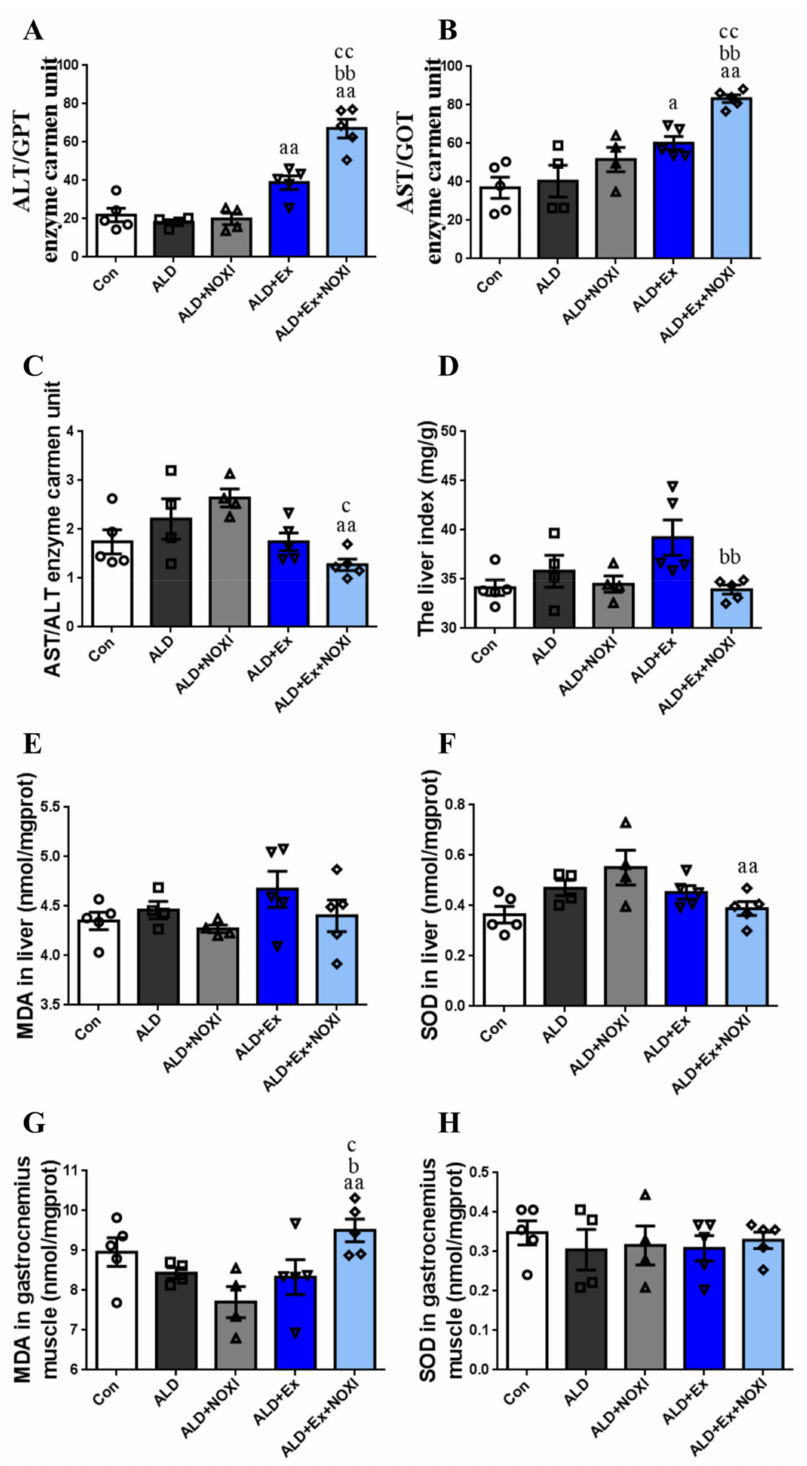
Figure 2. With the combined intervention of apocynin and exercise, oxidative stress levels were reduced in liver tissue and increased in gastrocnemius muscle tissue. ( A , B ) ALT and AST levels in serum. ( C ) Serum AST/ALT values. ( D ) The level index. ( E , F ) MDA and SOD levels in liver tissue. ( G , H ) MDA and SOD levels in gastrocnemius muscle tissue. The exercise effect is denoted by a, a p < 0.05, aa p < 0.01. The drug effect is denoted by b, b p < 0.05, bb p < 0.01. The effect of combined exercise and drug intervention is indicated by c, c p < 0.05, cc p <